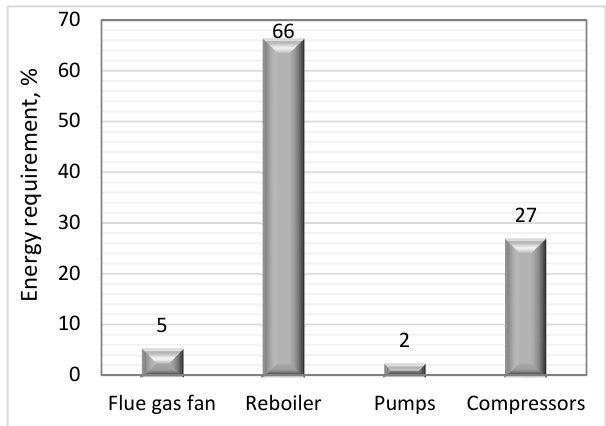
Figure 3. Overview of energy consumption.